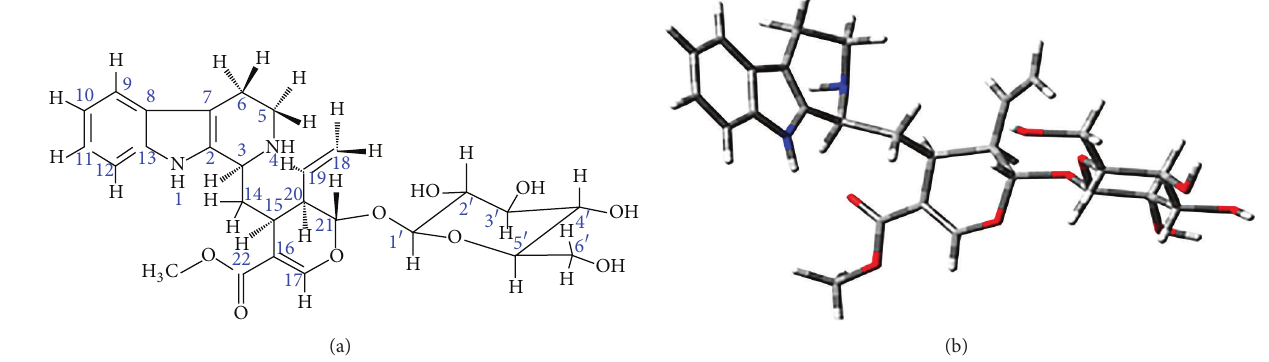
Figure 1: Structure of